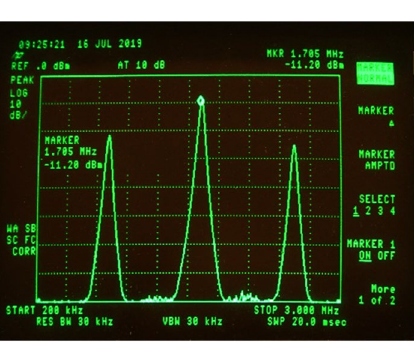
Fig. 8 Higher pump frequencies and broader signals are associ- ated with a larger pump intensities. The signal-to-noise ratio (SNR) is 60